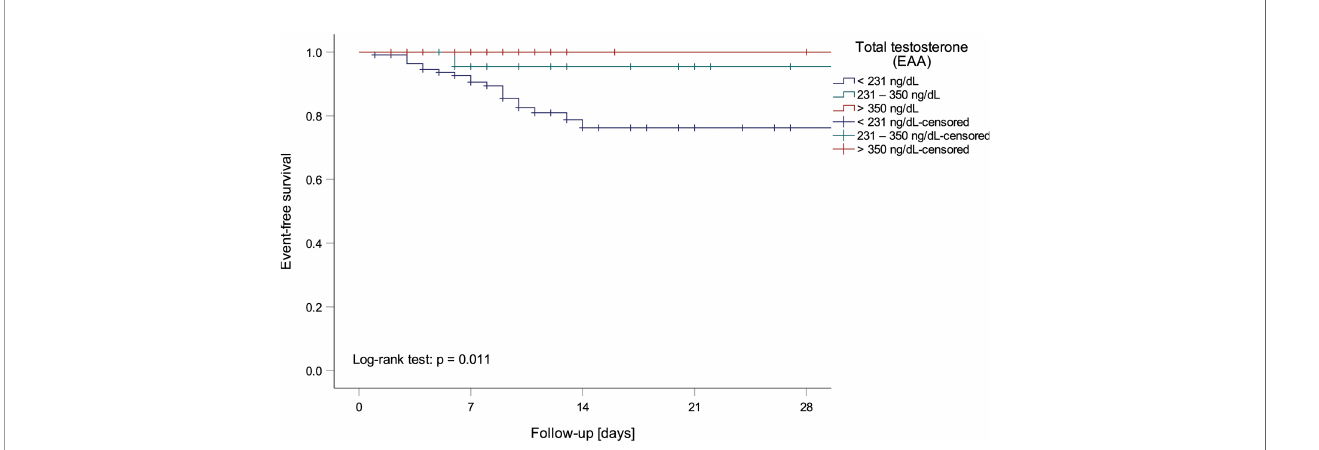
FIGURE 1 | Kaplan-Meier curve depicting mortality of men within testosterone normality ranges by the European Academy of Andrology (EAA)